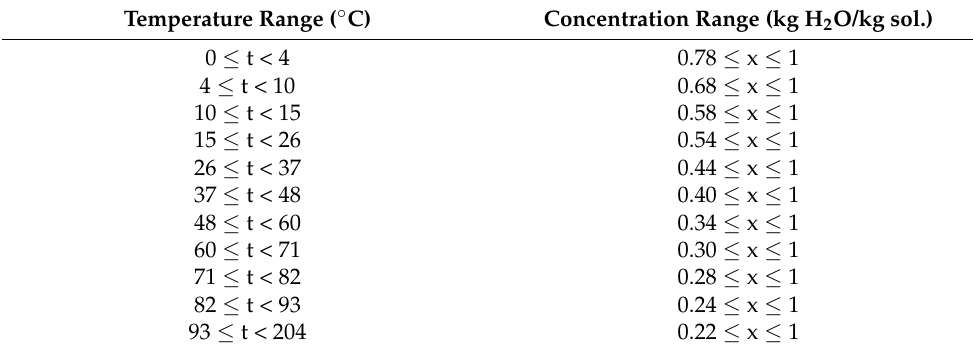
Table A32. Temperature range of the H 2 O-NaOH enthalpy